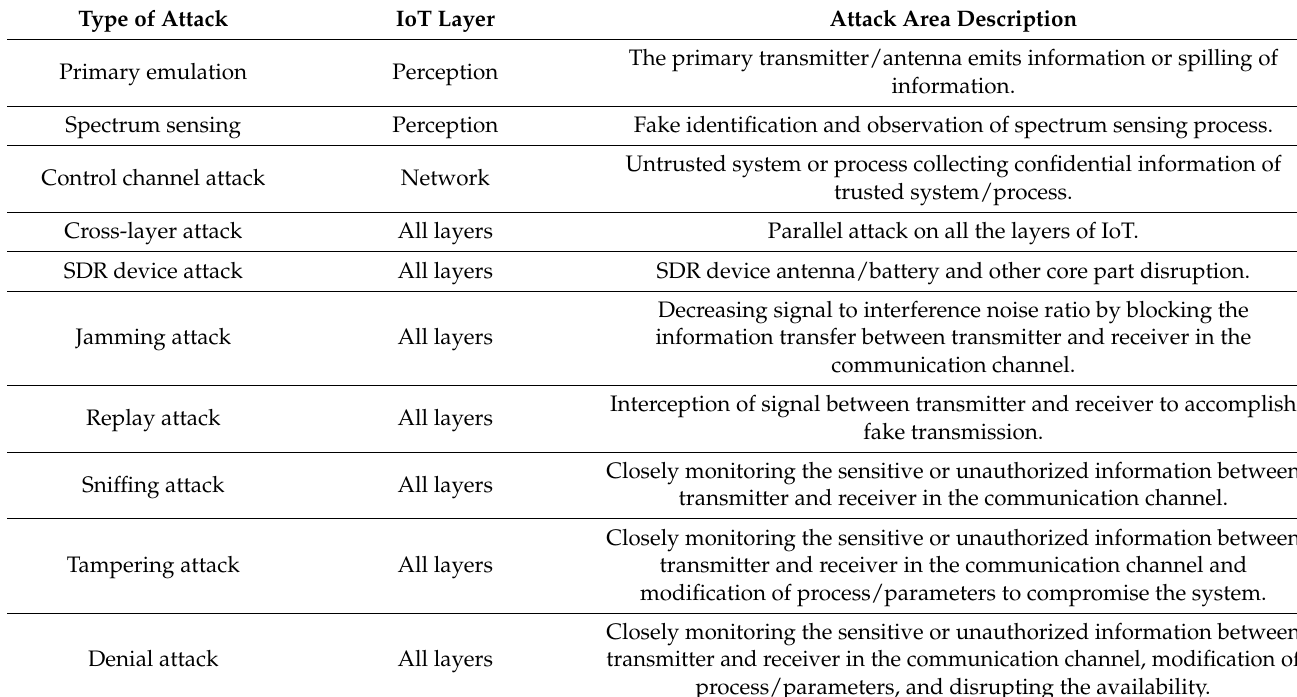
Table 1. RF attack by IoT layer and attack area